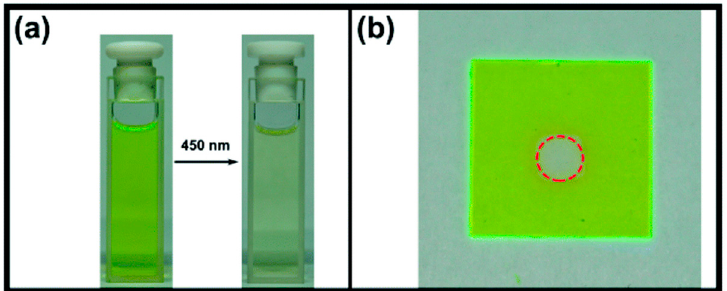
Figure 23. ( a ) Photolysis of 2-S ( a ) in acetonitrile, 450 nm irradiation (200 mW/cm 2 ). ( b ) Photobleach- ing during the thiol-ene polymerization of a TMPTA/PETMP blend. Reproduced with permission of Ref. [191] .